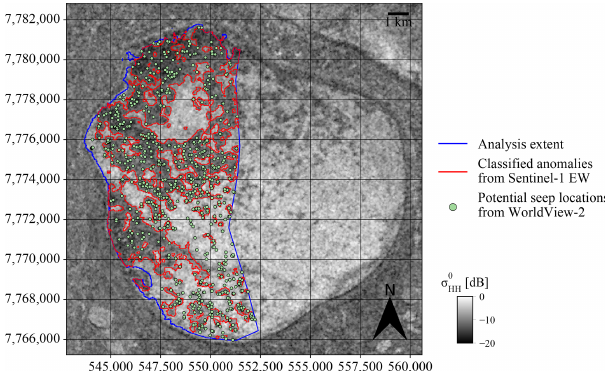
Figure 8. Comparison of detected holes (potential seep locations, green points) from WorldView-2 imagery acquired on 22 May 2016 and backscatter anomalies (red outlines) from a Sentinel-1 scene acquired on 16 May 2016 on top of the HH-polarisation band of the same scene. The blue outline shows the analysis extent that is determined by the extent of the WorldView-2 image and the lake and shelf masks. CRS: WGS 84 / UTM zone 42N.